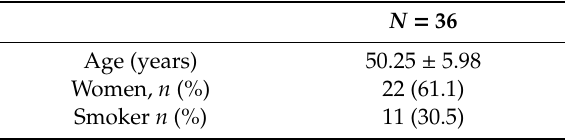
Table 1. Demographic characteristics at